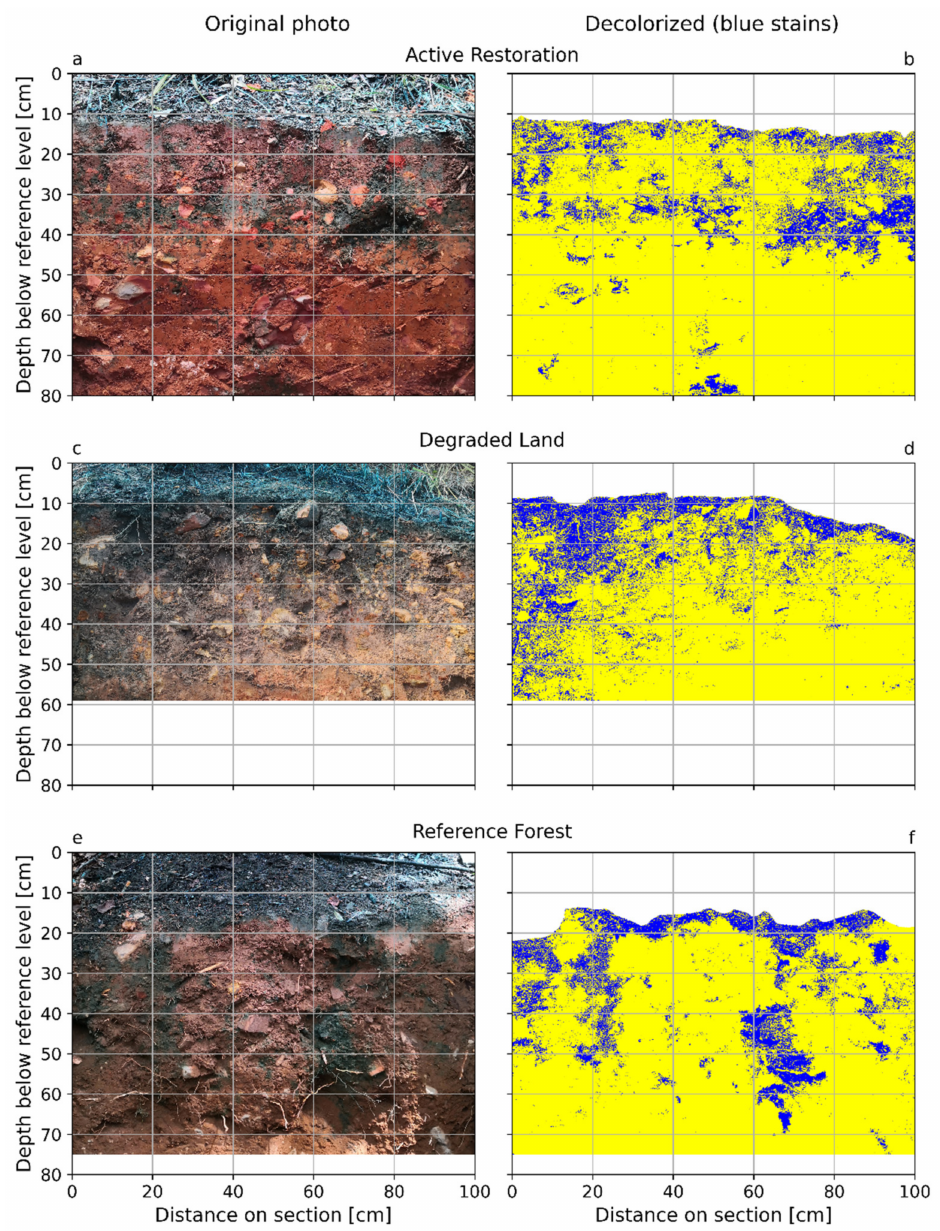
Figure 3. Dye tracer experiments showing the original photo during excavation ( a , c , e ) and the corrected dye infiltration patterns ( b , d , f ) for Active Restoration ( a , b ), Degraded Land ( c , d ), and Reference Forest ( e , f